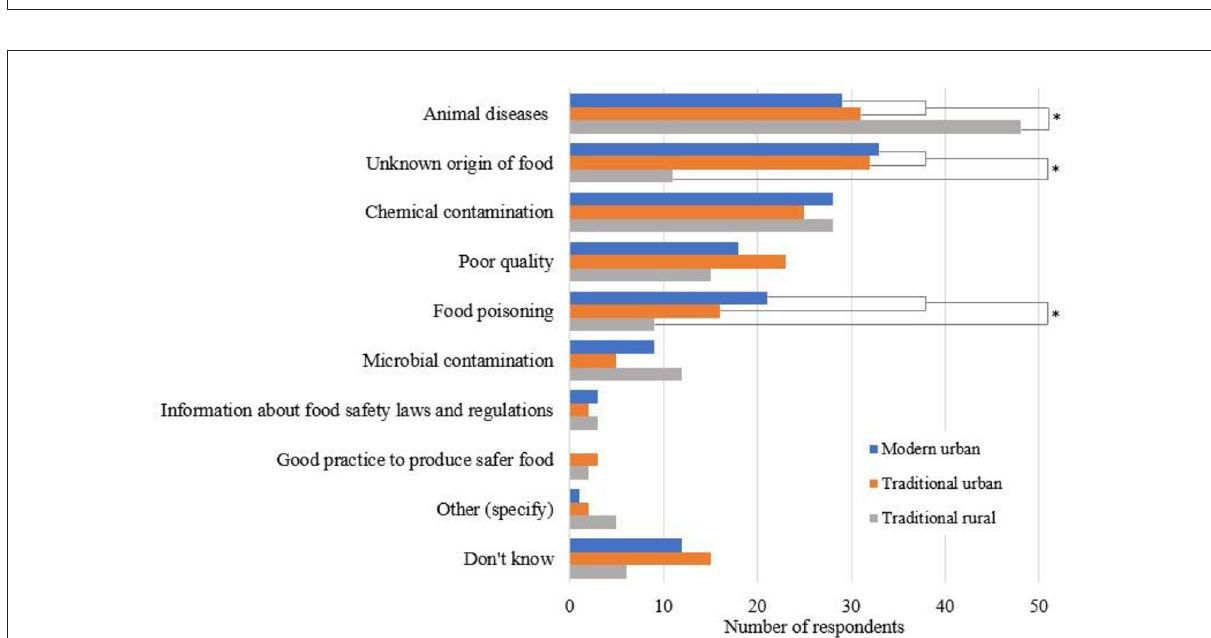
than the modern urban and traditional rural groups